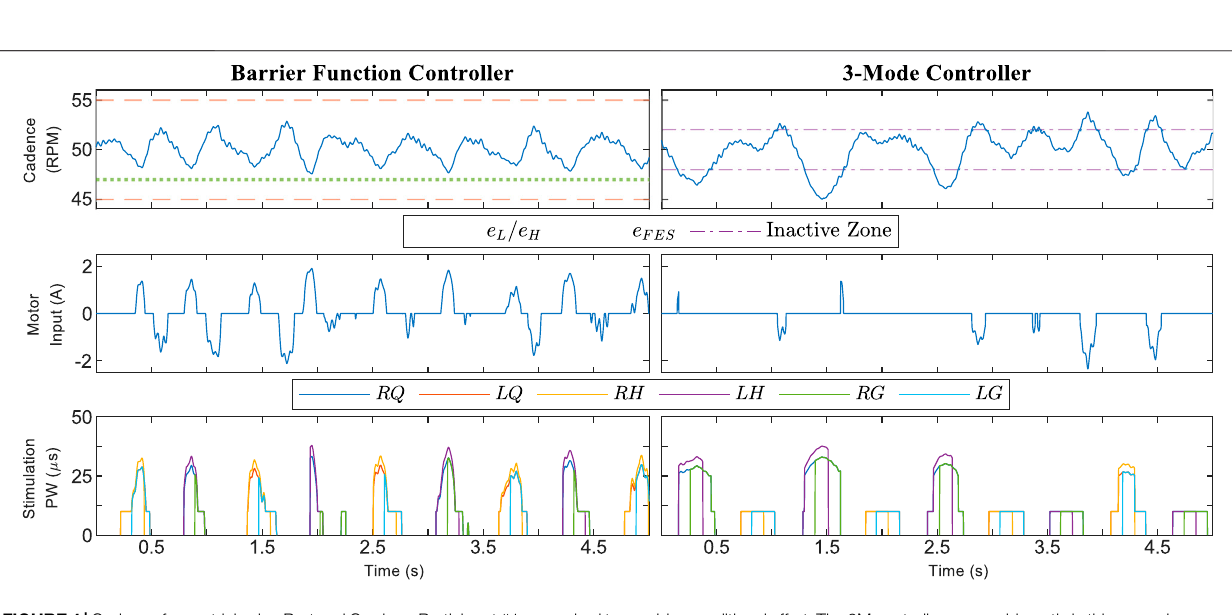
Frontiers in Robotics and AI |